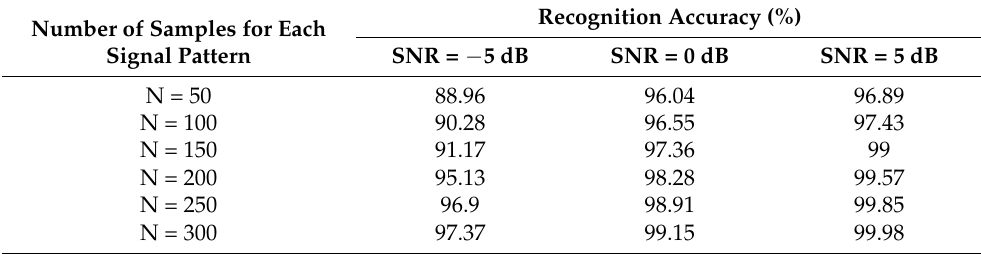
Table 5. Effects of different SNRs and different training set sample sizes on the recognition rate of CV-CNN